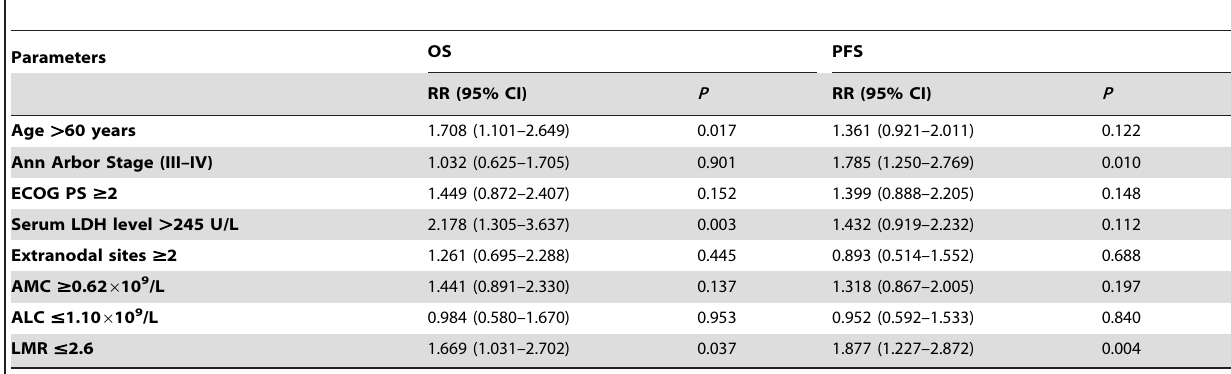
Table 3. Multivariate analysis of prognostic factors for survival in all patients with diffuse large B-cell lymphoma.